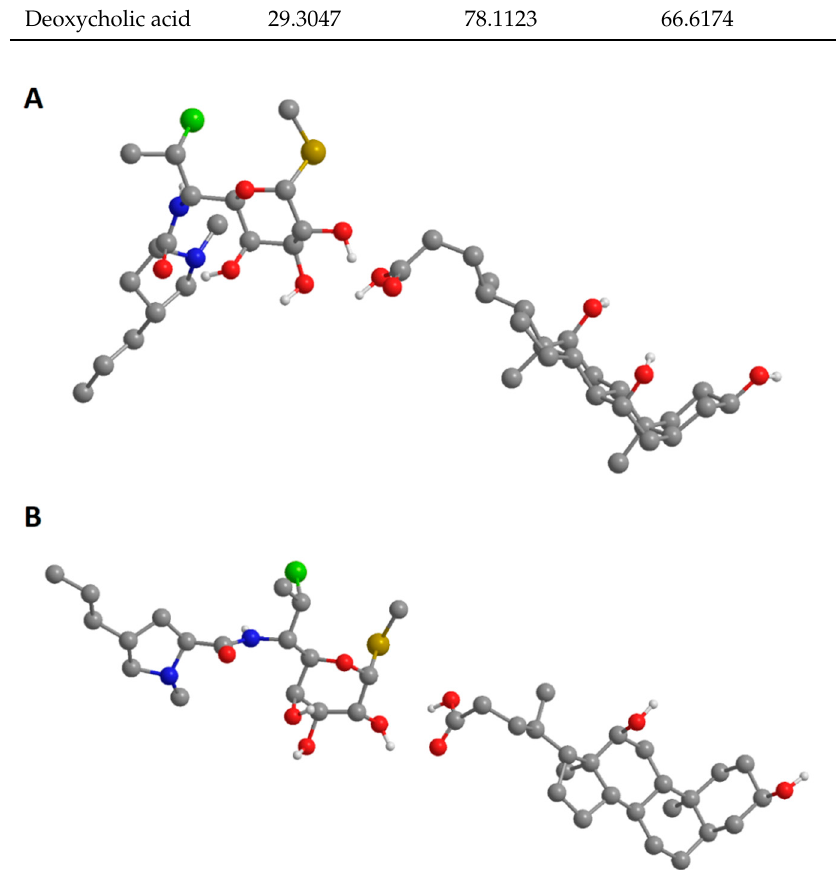
Figure 2. Geometrically optimized three-dimensional structures of clindamycin/cholic acid ( A ) and clindamycin/deoxycholic acid ( B ) complexes.